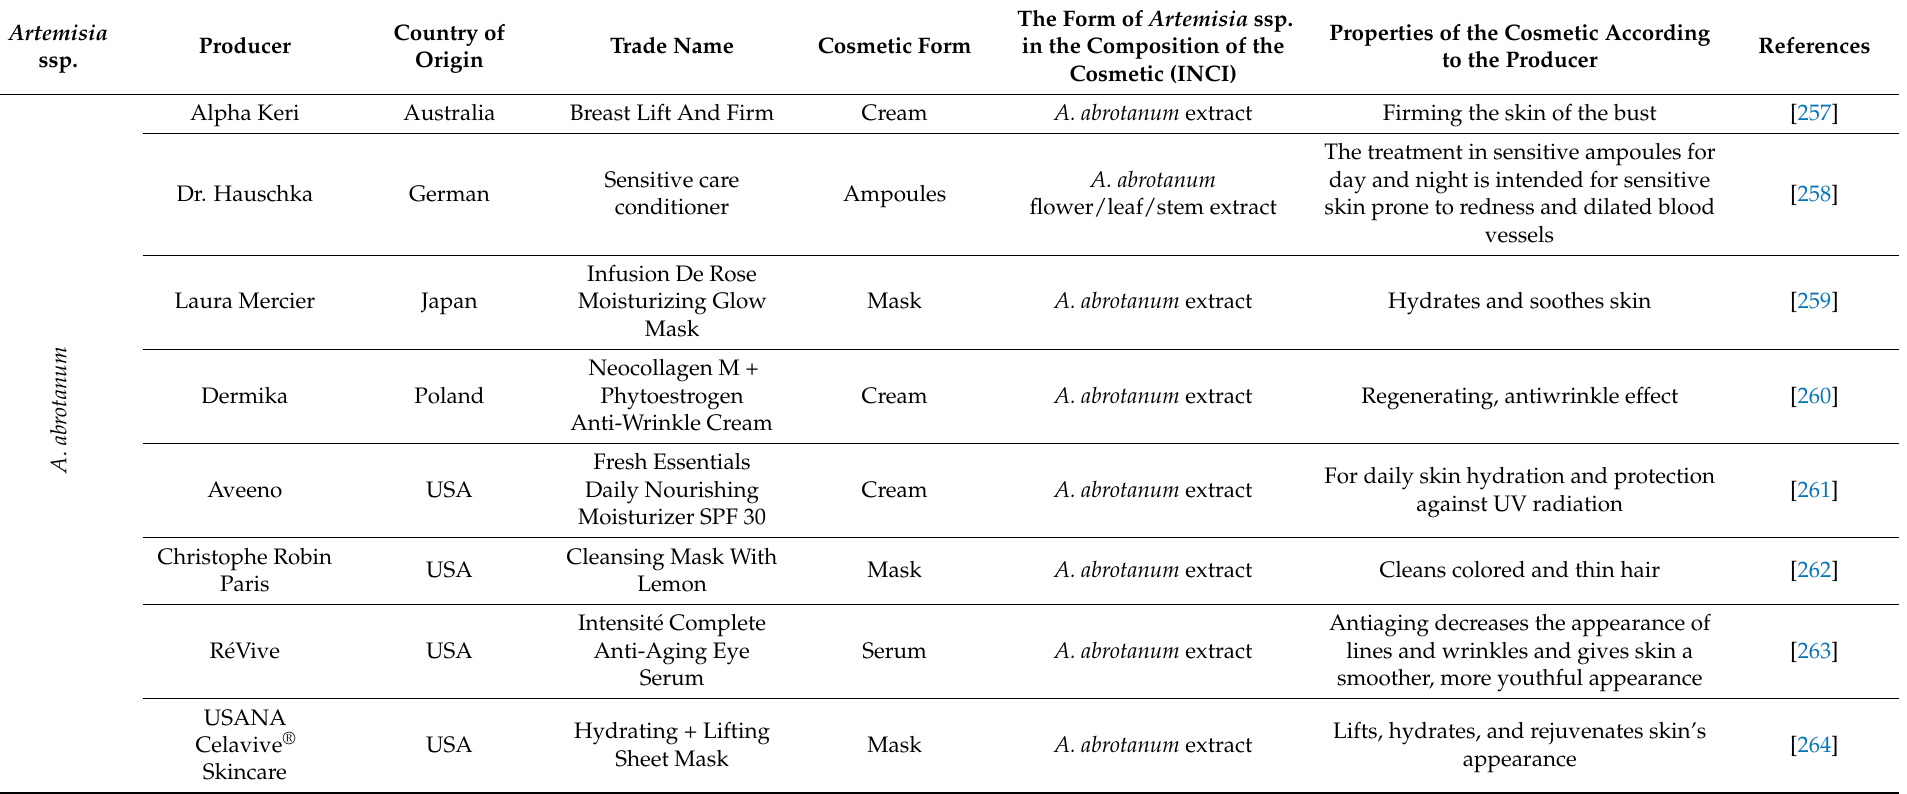
Table 8. Examples of some cosmetics based on Artemisia